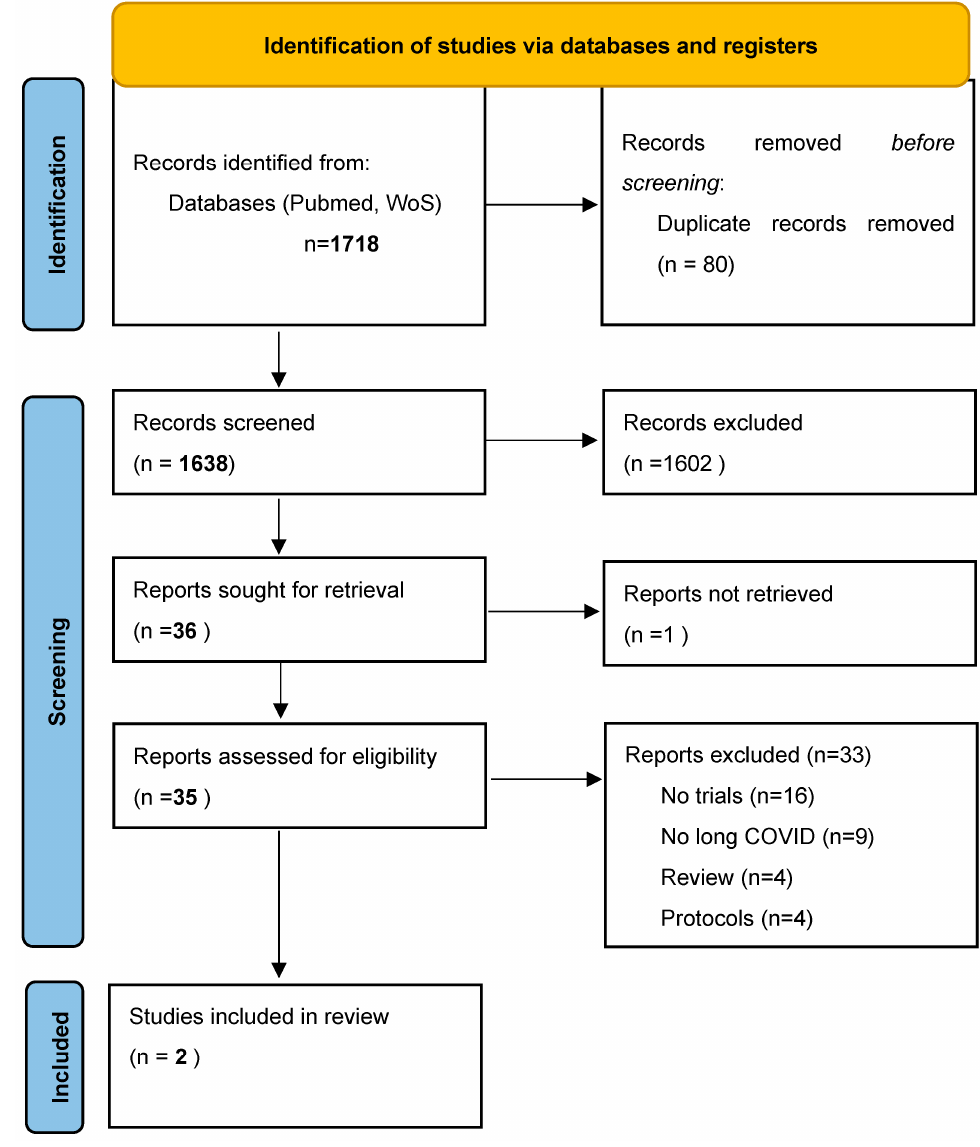
Figure 1. PRISMA flow